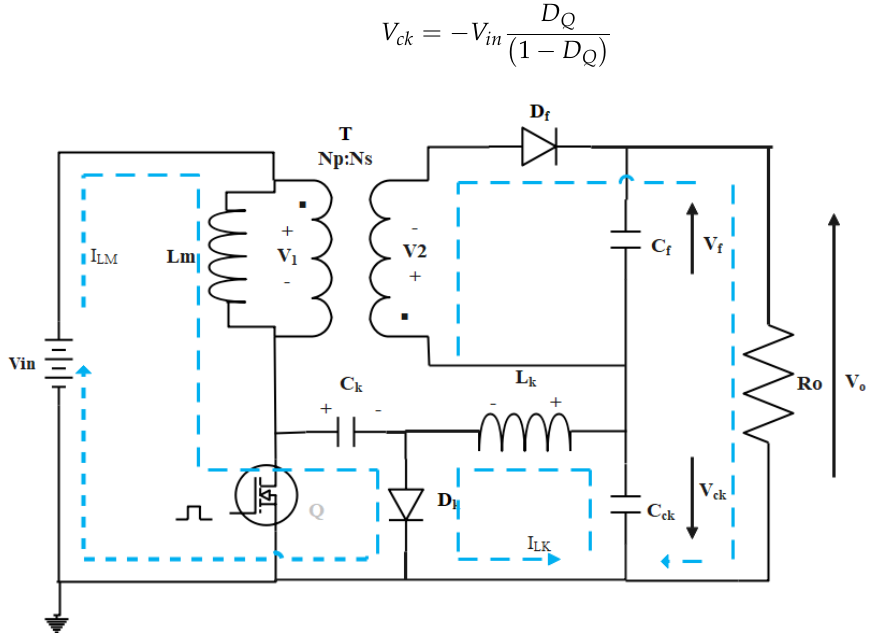
Figure 3. The proposed HFC converter (switch Q is